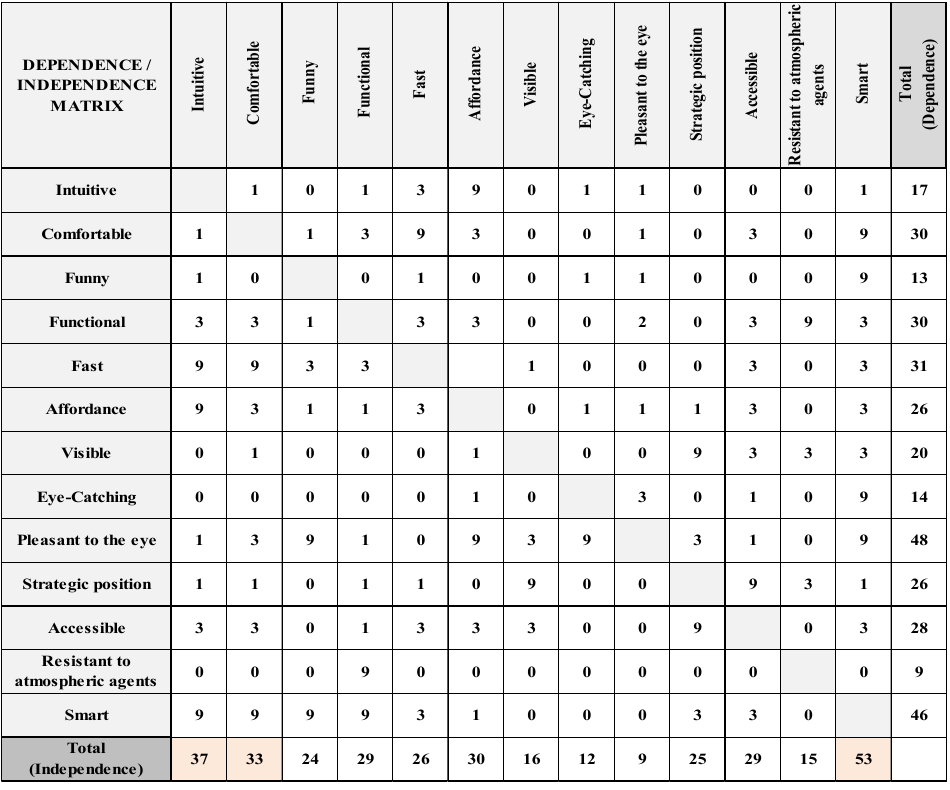
Figure 5. Dependence/Independence Matrix.